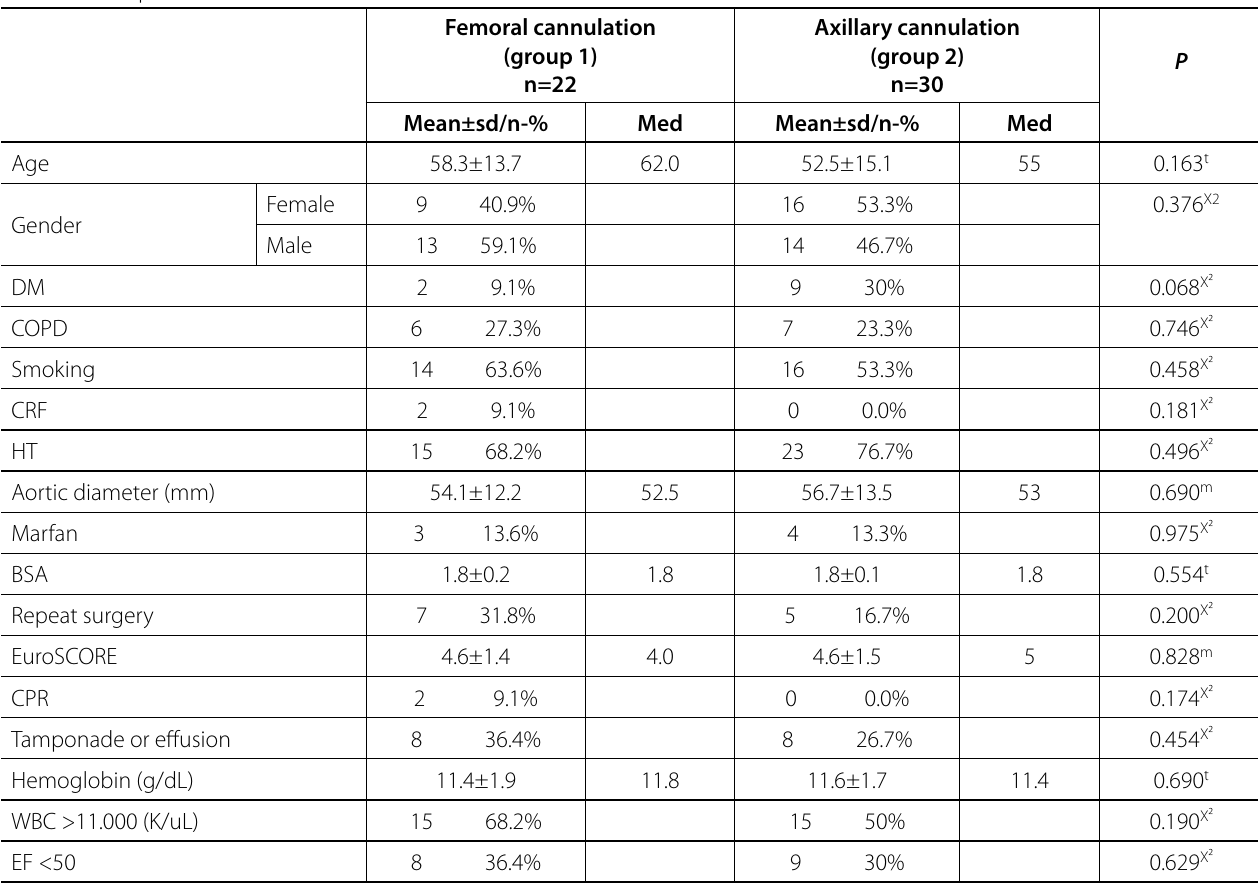
Table 1 . Preoperative